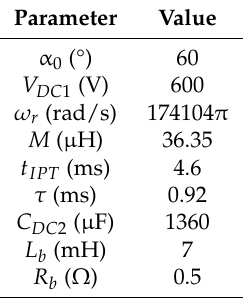
Table 1. Parameters employed to obtain the transfer functions P IPT ( s ) , P DC 2 ( s ) and P b ( s )